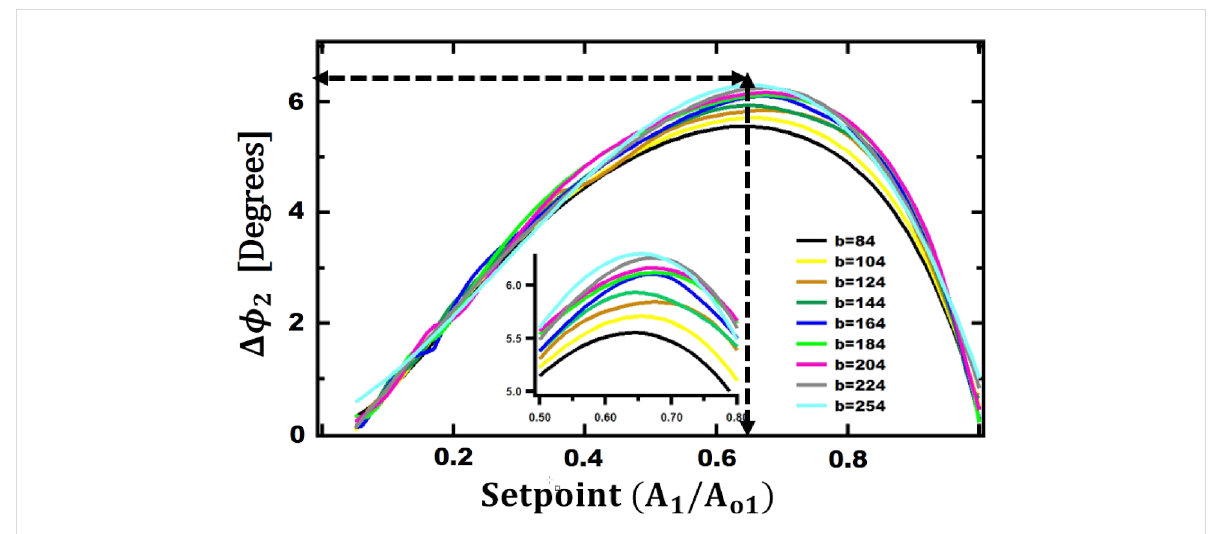
Figure 6: Second eigenmode phase difference between Au and PS as a function of the setpoint for a given cantilever base width. The other geomet- rical parameters are: L opt = 90 µm, = 15 µm, and t ref = 0.4 µm.